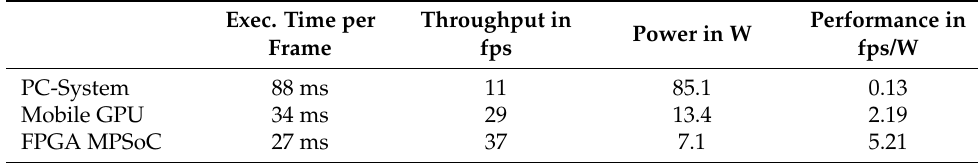
Table 5. PC-system, mobile GPU and FPGA